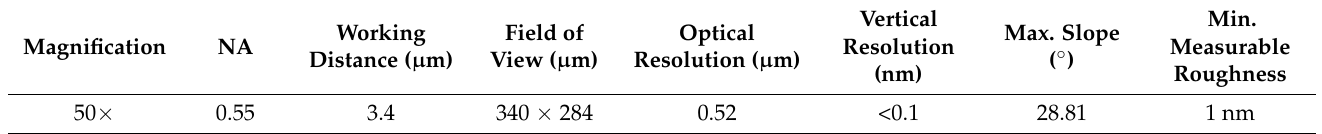
Table 1. Measurement characteristics of the Mirau interferometer for WLI Zygo NewView